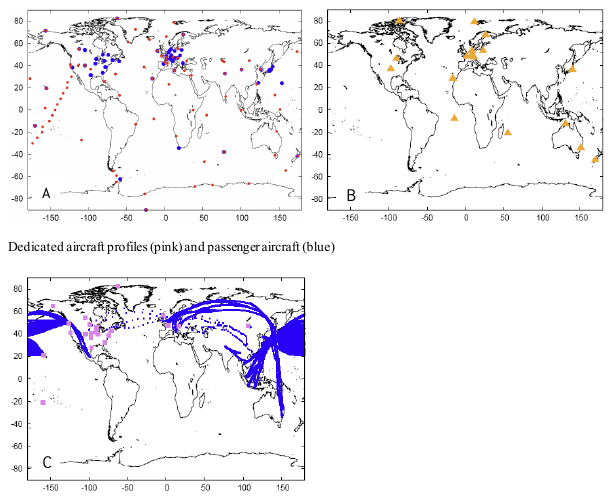
Figure 3. (A) Global network of CO 2 surface stations with flask sampling (red symbols) and continuous measurement sites (blue symbols). The data from these sites and from additional stations can be found at WMO GAW World Data Center for Greenhouse Gases (http://ds.data.jma.go.jp/gmd/wdcgg/). (B) Locations of the Total Column Carbon Observing Network by year 2012. These sta- tions are essential for satellite column CO 2 and CH 4 measurement validation. (C) Location of vertical profile sites, where GHG mix- ing ratios are measured by dedicated aircraft on a typical monthly basis (pink symbol), and location of passenger instrumented aircraft program flights CONTRAIL and CARIBIC (blue